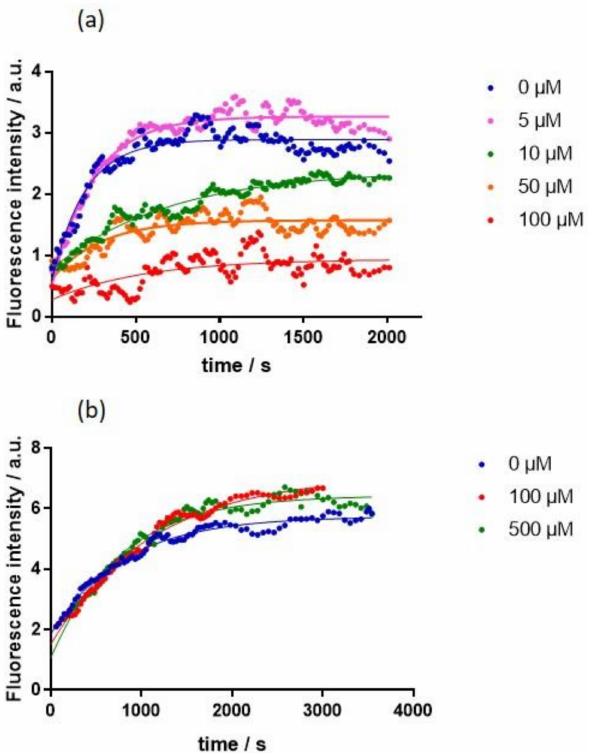
Figure 3. Fluorescence competition experiments of enzymatic cleavage. ( a ) Enzymatic transfor- mation of 0.5 µ M of N -Cbz-GGR-AMC by urokinase (0.5 U) in the presence of increasing GdL3 concentrations (0–100 µ M). pH 7.5, 37 ◦ C, BSA 7 mg/mL; λ ex = 365 nm, λ em = 440 nm. ( b ) Enzymatic transformation of 0.7 µ M of N -acetyl-DEVD-AFC by caspase-3 (0.005 U) in the presence of increasing GdL4 concentrations (0–500 µ M). pH 7.4, 37 ◦ C; λ ex = 380 nm, λ em = 460 nm. Lines are drawn to show the